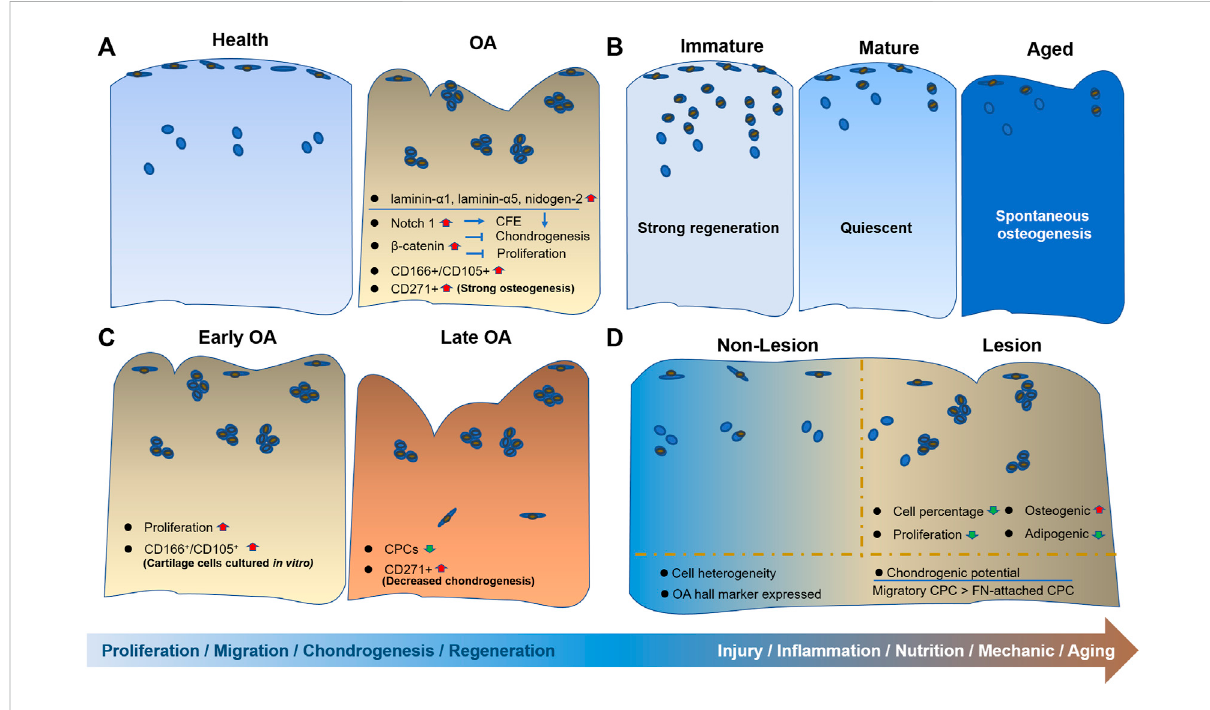
FIGURE 1 ThealterationsofCPCsduringaginganddiseaseprogression.SchematicoverviewofCPCalterationsisdepictedindifferentstagesofcartilage, including (A) from healthy to OA cartilage; (B) from immature to aged cartilage; (C) from early OA to late OA cartilage; and (D) the comparison between nonlesion and lesion